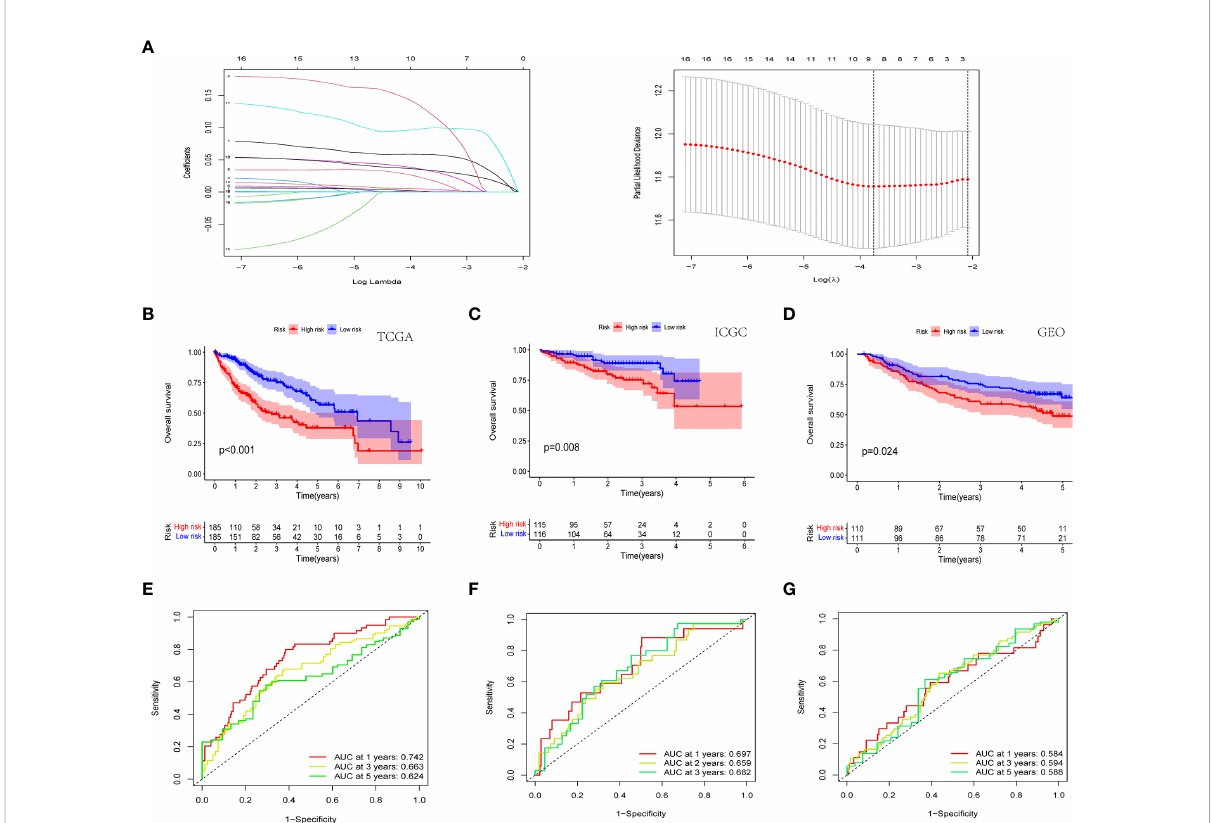
FIGURE 3 Novel histone phosphorylation-related genes risk signature. (A) LASSO regression screening model genes. Survival analysis of high- and low-risk groups in the TCGA cohort (B) ICGC cohort (C) and GEO cohort (D) . ROC curve analysis for predicting overall survival in HCC patients based on